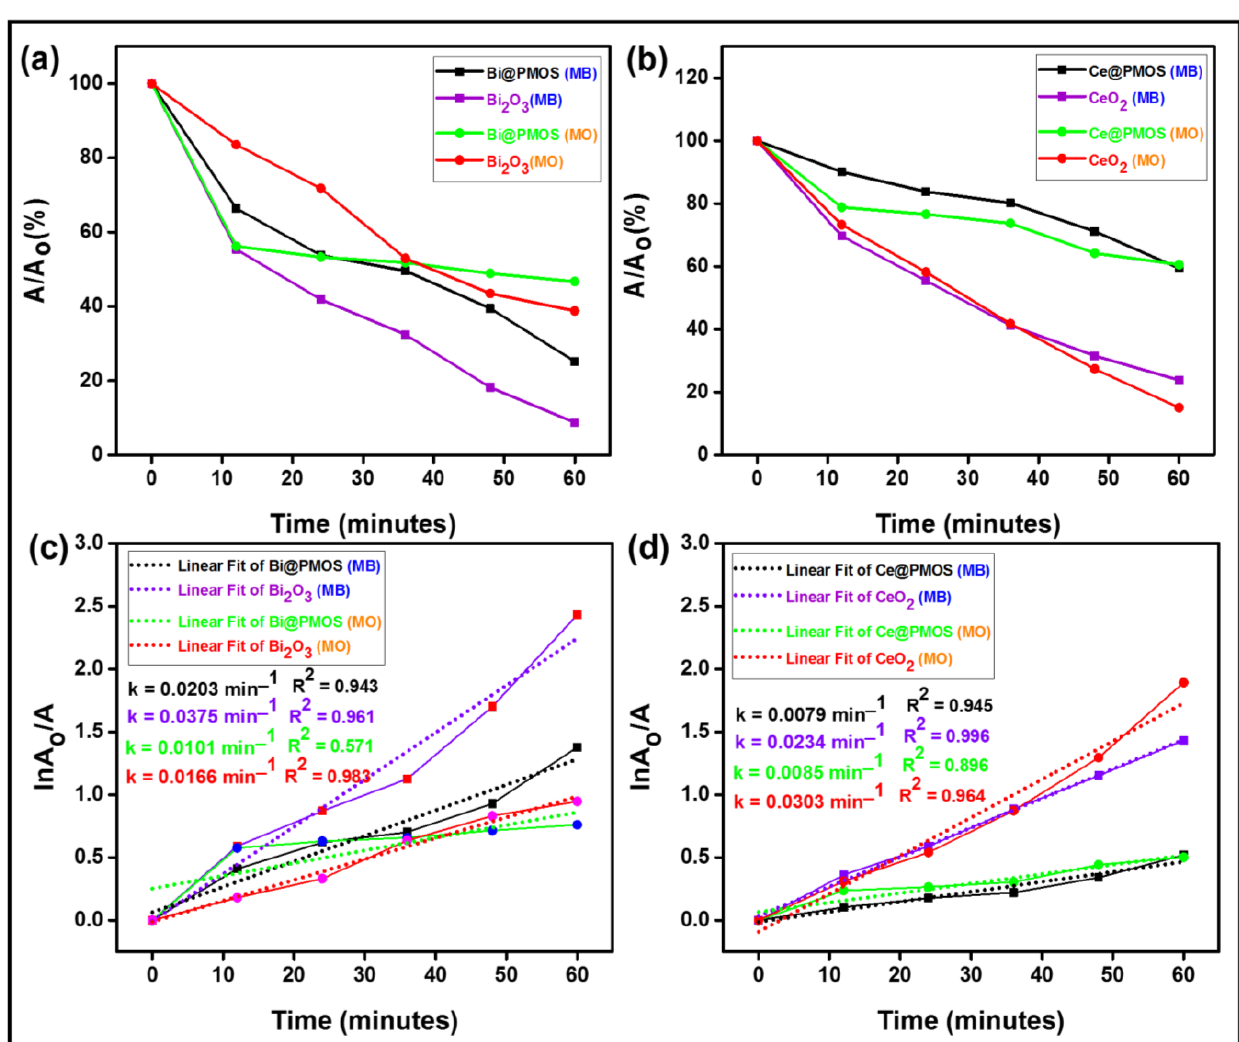
Figure 4. ( a , b ) %Photoreduction and ( c , d ) kinetic study of methylene blue and methyl orange under visible light.